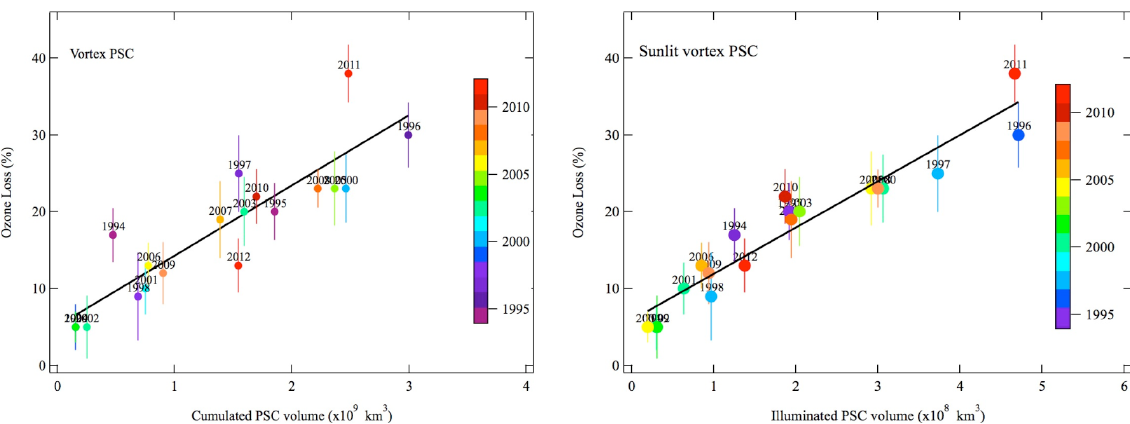
Fig. 12. Relationship between SAOZ total column ozone loss and V PSC between 400–675K calculated from ERA-Interim temperatures. Figure 12. Relationship between SAOZ total column ozone loss and V Left: V PSC inside vortex; right: sunlit V PSC only, indicative of potential chorine activation. The selection of sunlit V PSC instead of total V PSC increases the correlation from 0.88 to 0.95. Although V PSC was similar or larger in 1996 than in 2011, the ozone loss was smaller, implying calculated from ERA-Interim temperatures. Left: V that another proxy, the state of denitrification, is controling its amplitude. indicative of potential chorine activation. The selection of sunlit V increases the correlation from 0.88 to 0.95. Although V